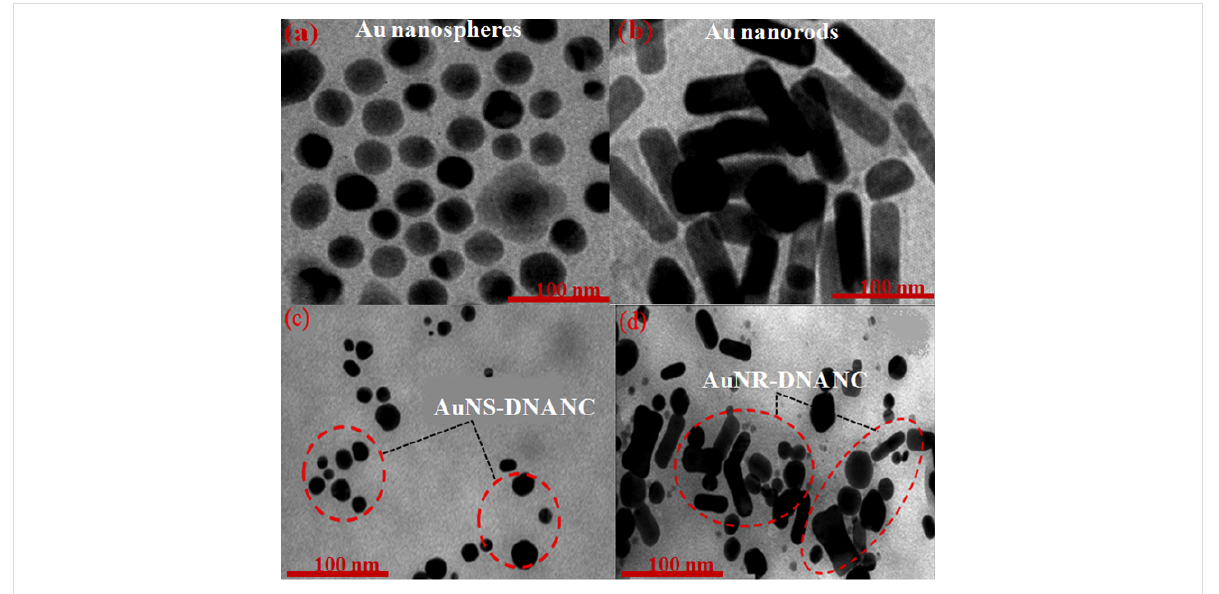
Figure 3: TEM images of bare (a) AuNSs, (b) AuNRs, (c) AuNS–DNA and (d) AuNR–DNA nanocomposites.